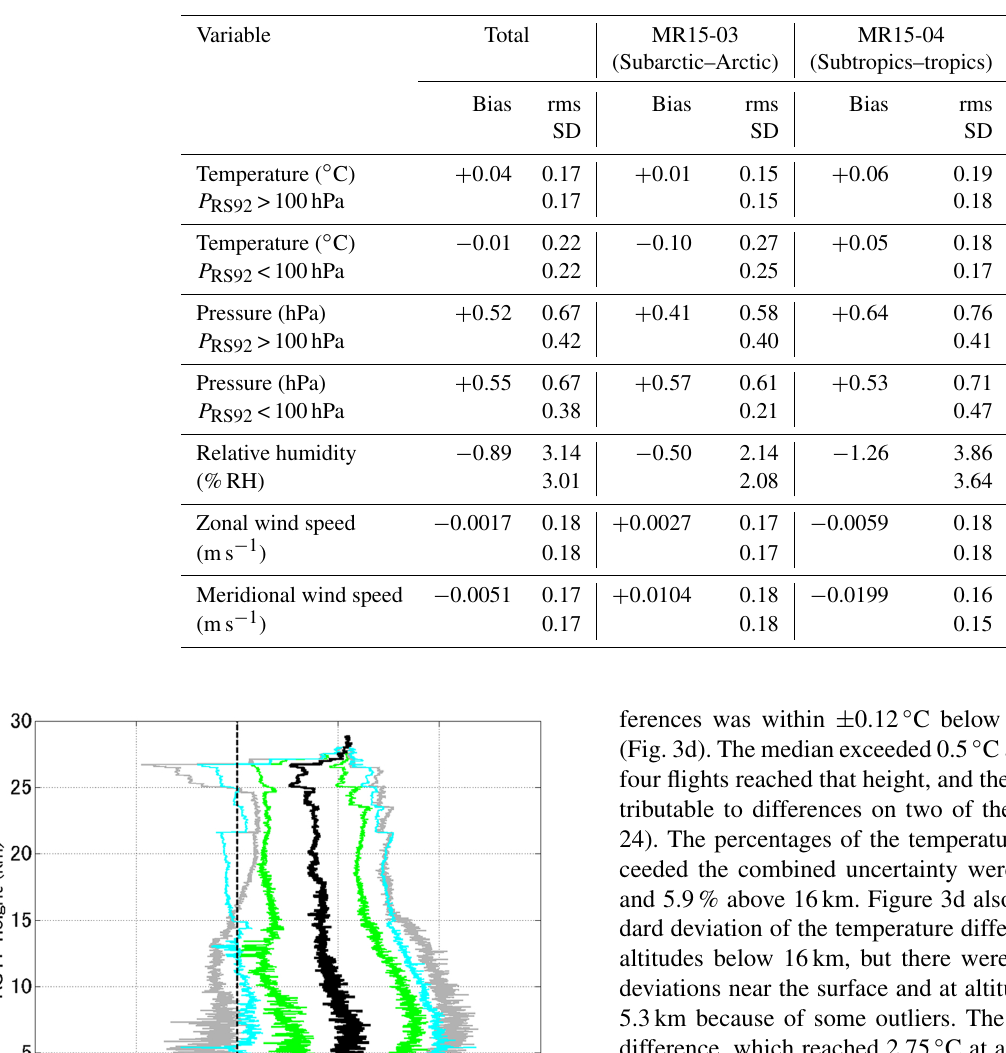
Table 3. Biases, rms differences, and standard deviations (SDs) of the variables between the RS92 and RS41 radiosondes. The bias is the mean of RS92–RS41 differences.